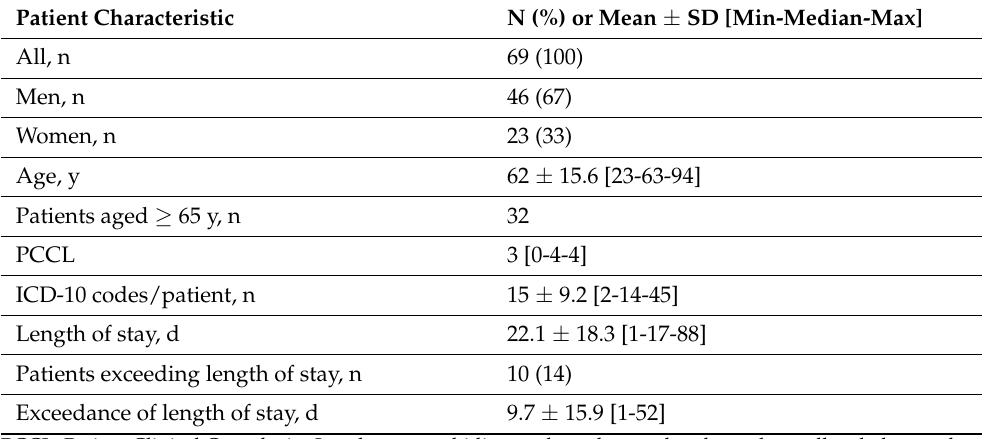
Table 2. Patient characteristics of the 69 inpatients with one of the ICD-10 codes coding for drug- induced nephropathy or postprocedural renal